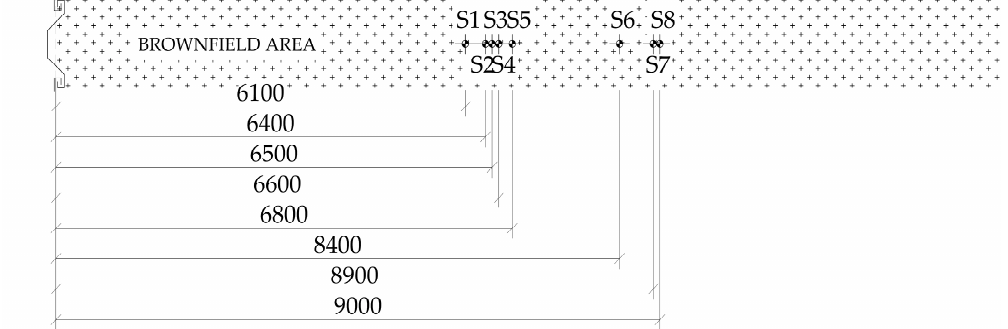
Figure 7. Measurement situation—vibrated sheet piles.